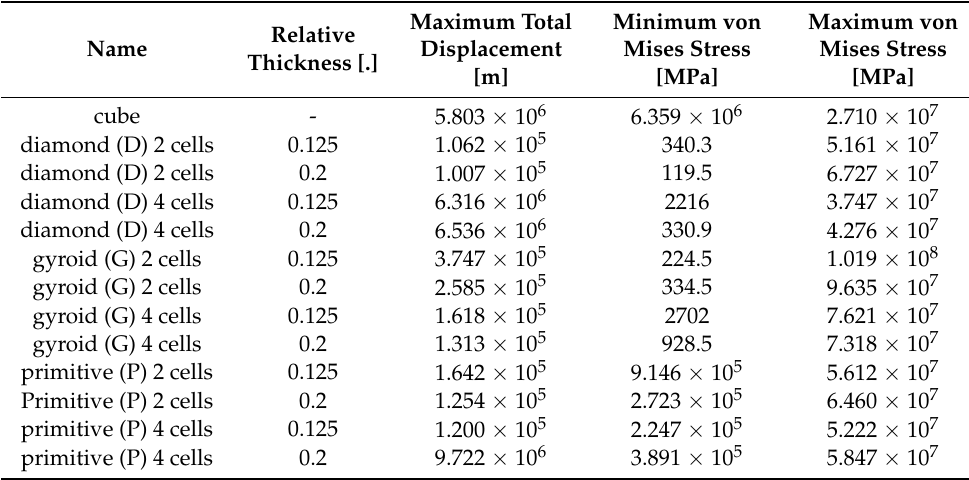
Table 4. Maximum total displacement, maximum and minimum von Mises stress from elastic stress